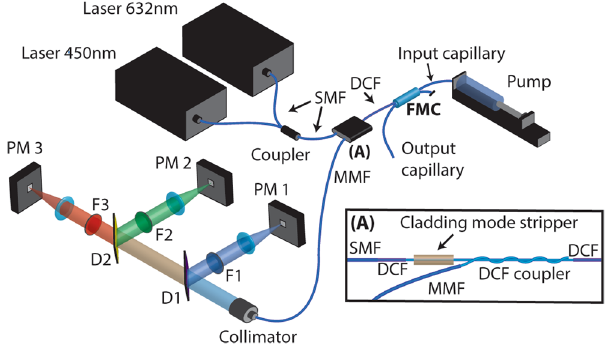
Figure 5. Experimental setup. SMF: single mode fibre, FMC : fibre micro-chamber (Fig. 1(a)). DCF: double- clad fibre. MMF: multi-mode fibre: F1, F2, F3: bandpass filter. D1, D2: dichroic mirror. PM 1,PM 2,PM 3 silicon